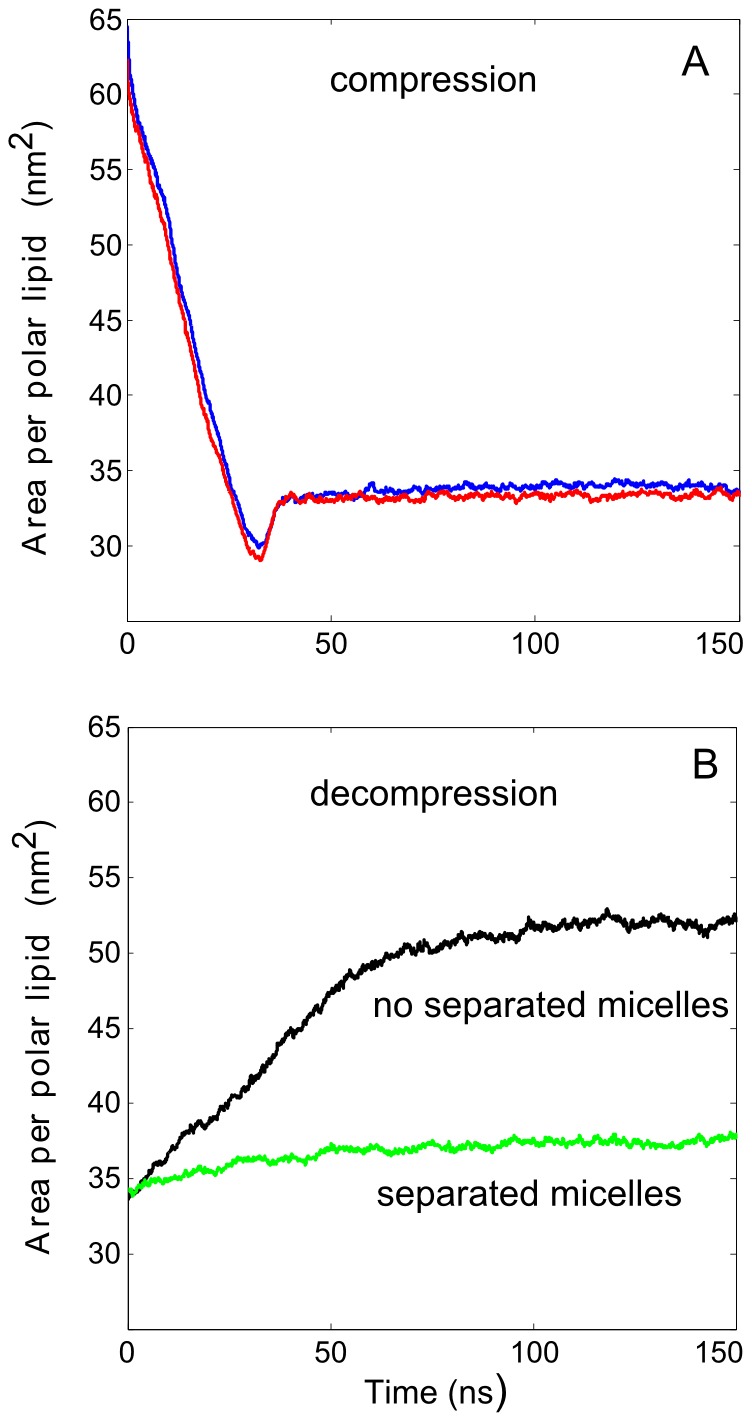
The area per polar lipid as a function of simulation time in non-equilibrium simulations of lateral compression.The lateral pressure of 1 bar was used, each curve represents an independent MD trajectory (A); and decompression under the lateral pressure of at −6 bars (B) with the decompression simulation initiated either prior (black curve) or after (green curve) the inversed micelles separated from the polar monolayer in a previous simulation of lateral compression.